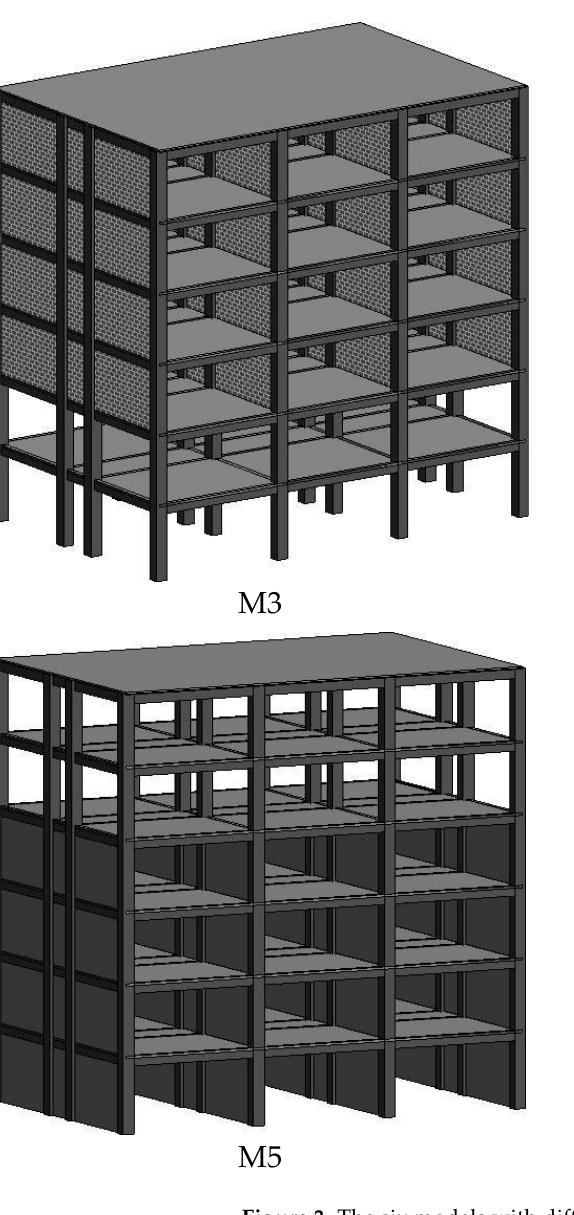
Figure 3. The six models with different infill wall arrangements.